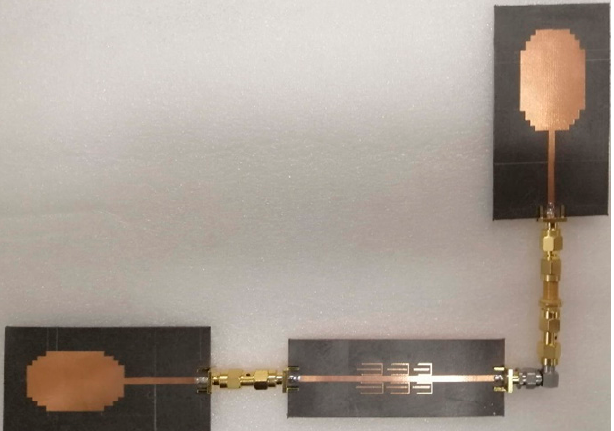
Figure 16. Integrated chipless RFID tag prototype.